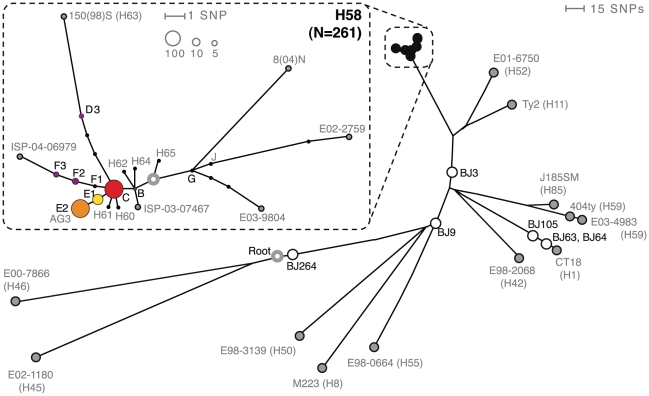
Phylogenetic distribution of S. Typhi isolates.Grey nodes represent control isolates (labelled by isolate code and haplotype group), unfilled grey circle indicates tree root, white nodes correspond to non-H58 S. Typhi isolated in this study (labelled with isolate code), black nodes show H58 isolates. Inset: zoom-in on the H58 haplogroup; grey nodes represent control isolates (labelled by isolate code or haplotype code), unfilled grey circle indicates tree root; coloured circles indicate nodes corresponding to H58 S. Typhi isolated in this study, node labels are as in the text, node colours are as in Figures 3–4, node sizes indicate the number of isolates on the scale as indicated by numbered circles.